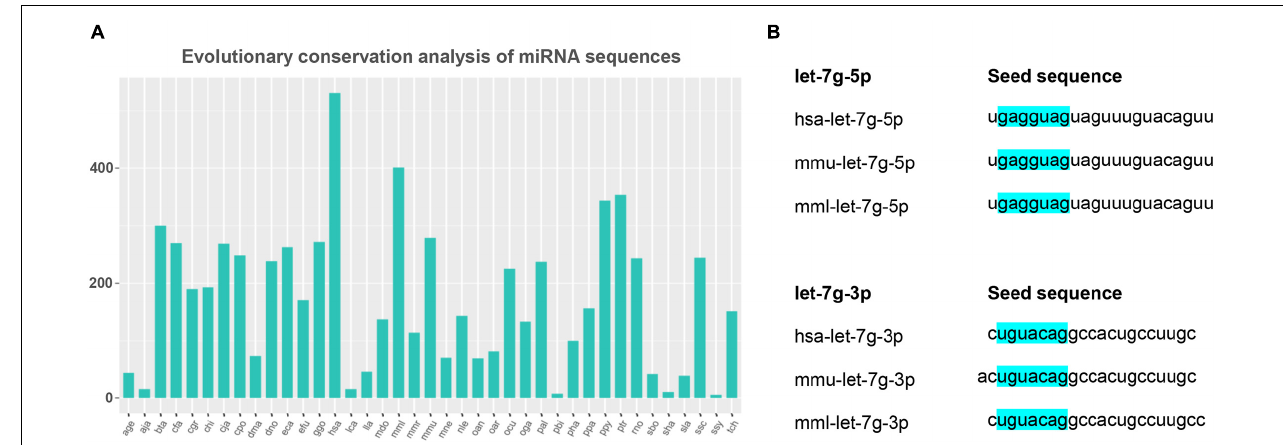
FIGURE 5 | Evolutionary conservation analysis of miRNA sequences and seed mml-let-7g sequence. (A) The conservation of miRNA in different species. The horizontal coordinates above represent different species, and the ordinate indicates the number of times the precursor appears in the species. (B) The seed sequence of mml-let-7g-5p and mml-let-7g-3p_1ss22CT in human, rhesus monkey, and mouse, which is highlighted in